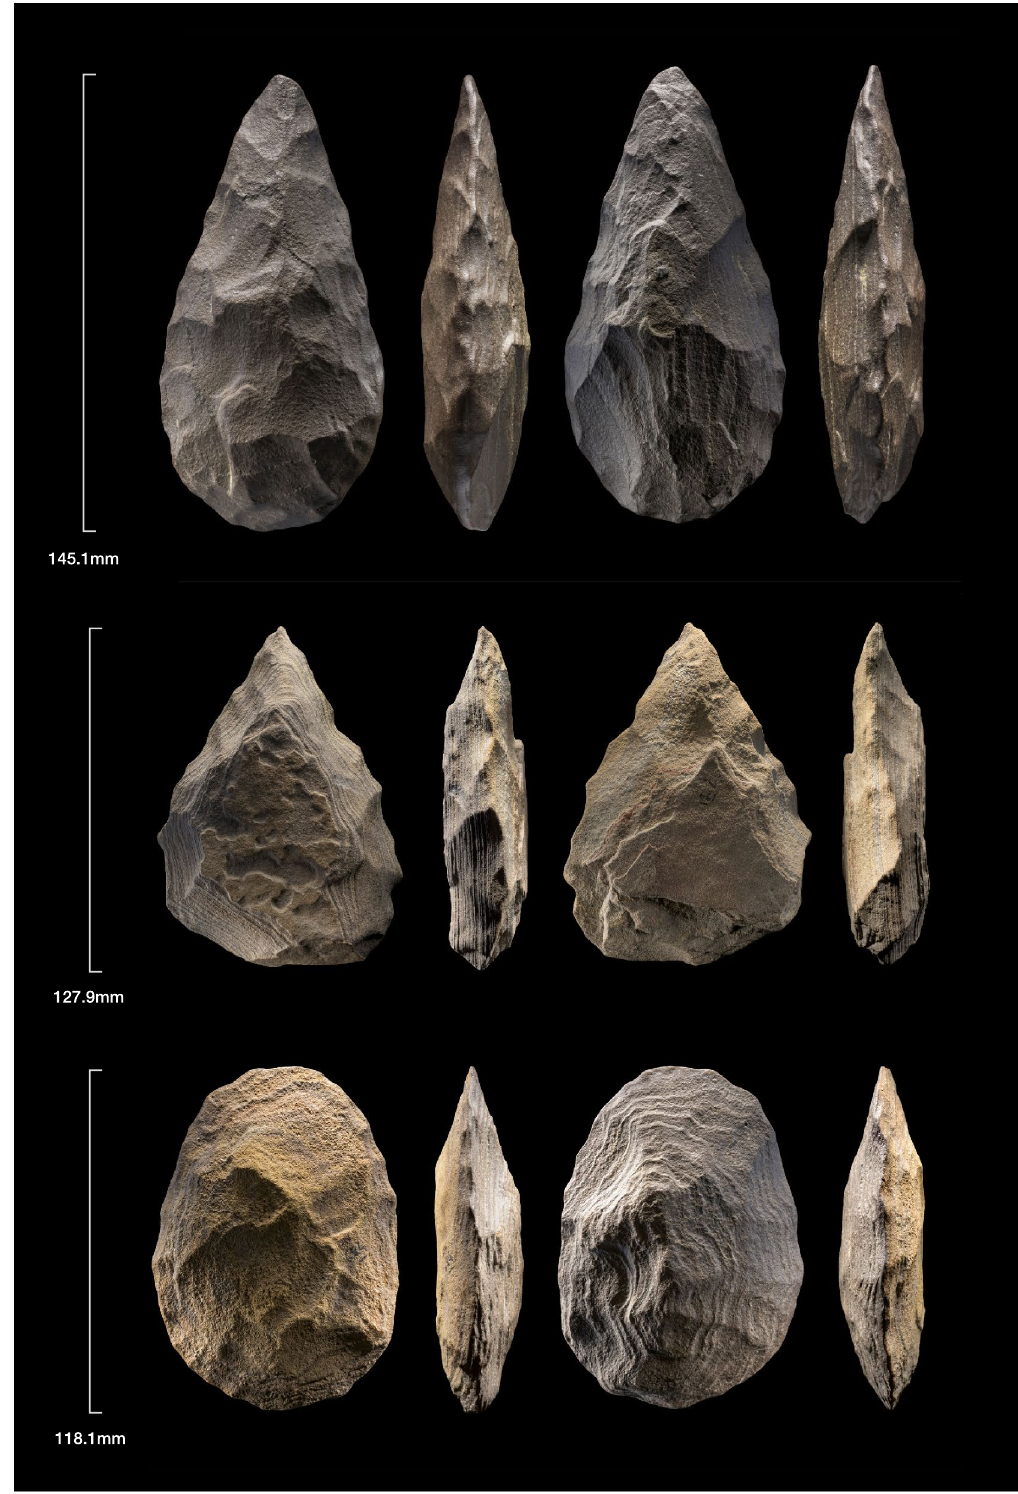
Figure 3. Different handaxe forms from An Nasim. Credit: Ian